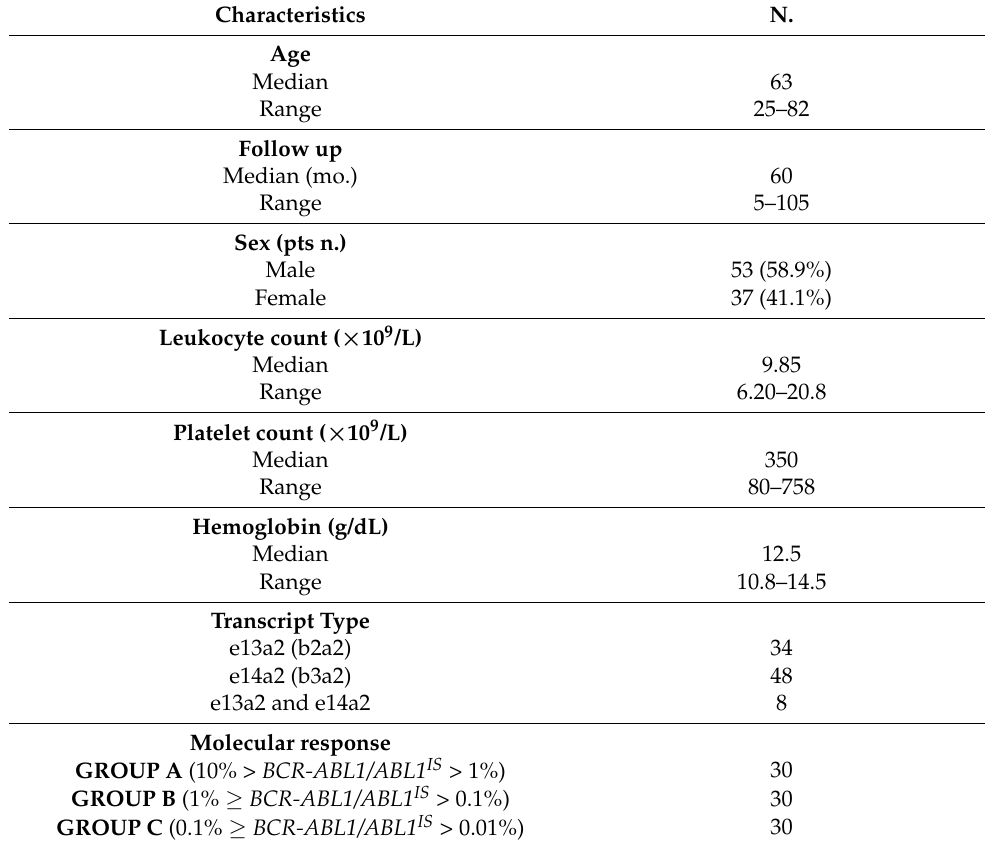
Table 1. Patient Characteristics ( N = 90).